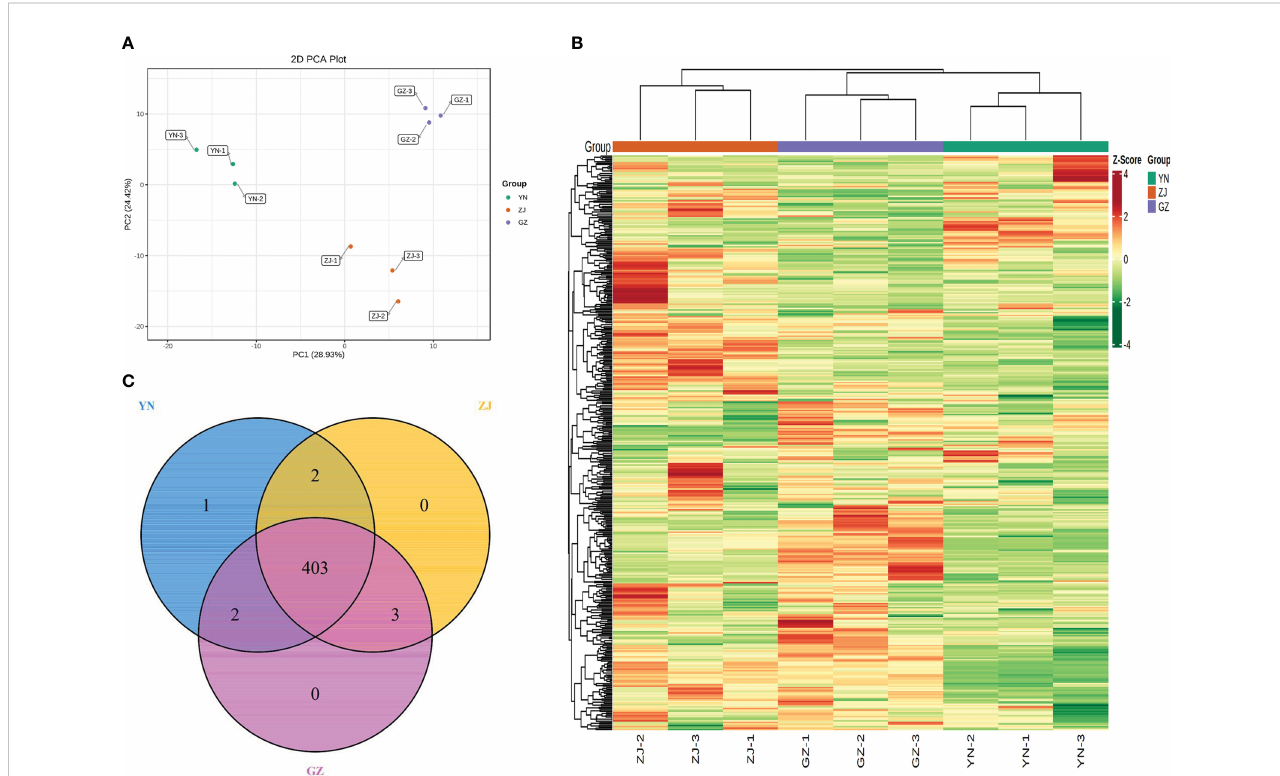
FIGURE 2 Overview of metabolites analysis detected in three Dendrobium of fi cinale provenances. (A) Principal component analysis of the relative of metabolites for YN, ZJ and GZ: (B) Cluster heatmap of metabolite content in different samples. (C) Venn diagram of metabolite distribution in different